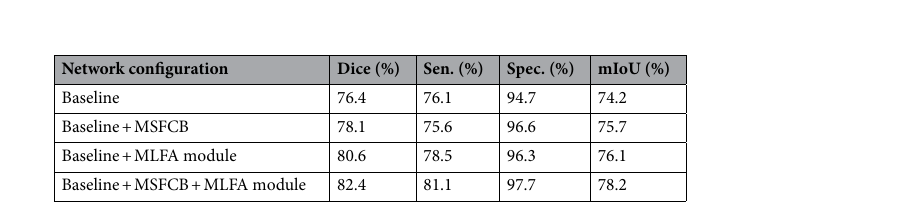
Table 3. Comparison of networks with different modules.